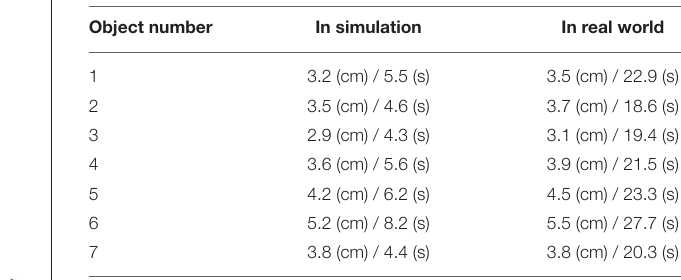
TABLE 3 | Comparison of pushing